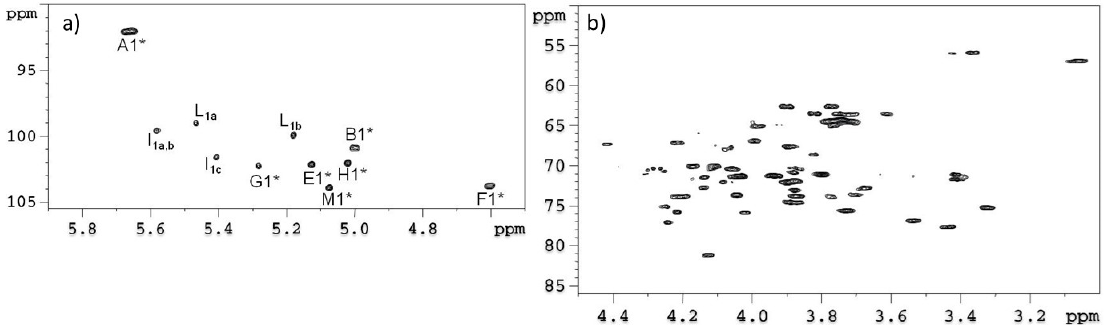
Table 1. Composition of the main species observed in the charge deconvoluted ESI FT-ICR mass spectrum of the totally deacylated LPS (L-OS KOH ) from a E. amylowora waaL mutant (Ea Δ waaL). Species Observed Mass (Da) Calculated Mass (Da)